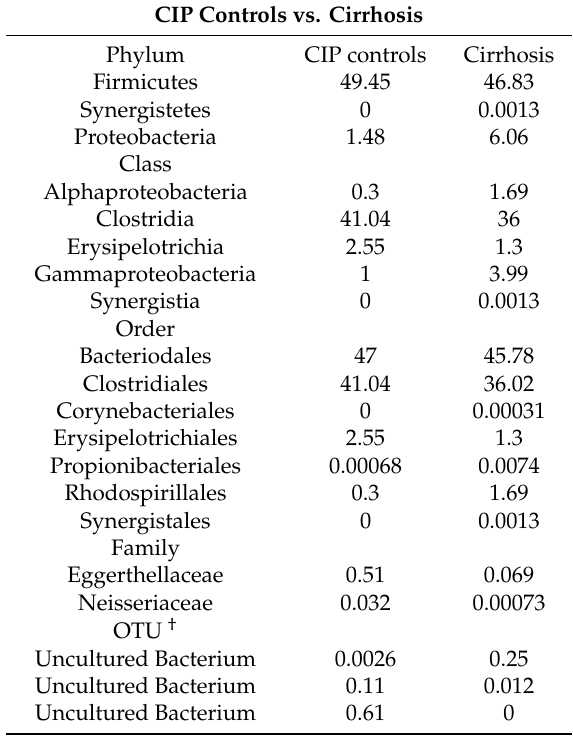
Table 10. Taxonomic di ff erences found with analysis of composition of microbiomes between CIP controls and the cirrhosis group on all taxonomic